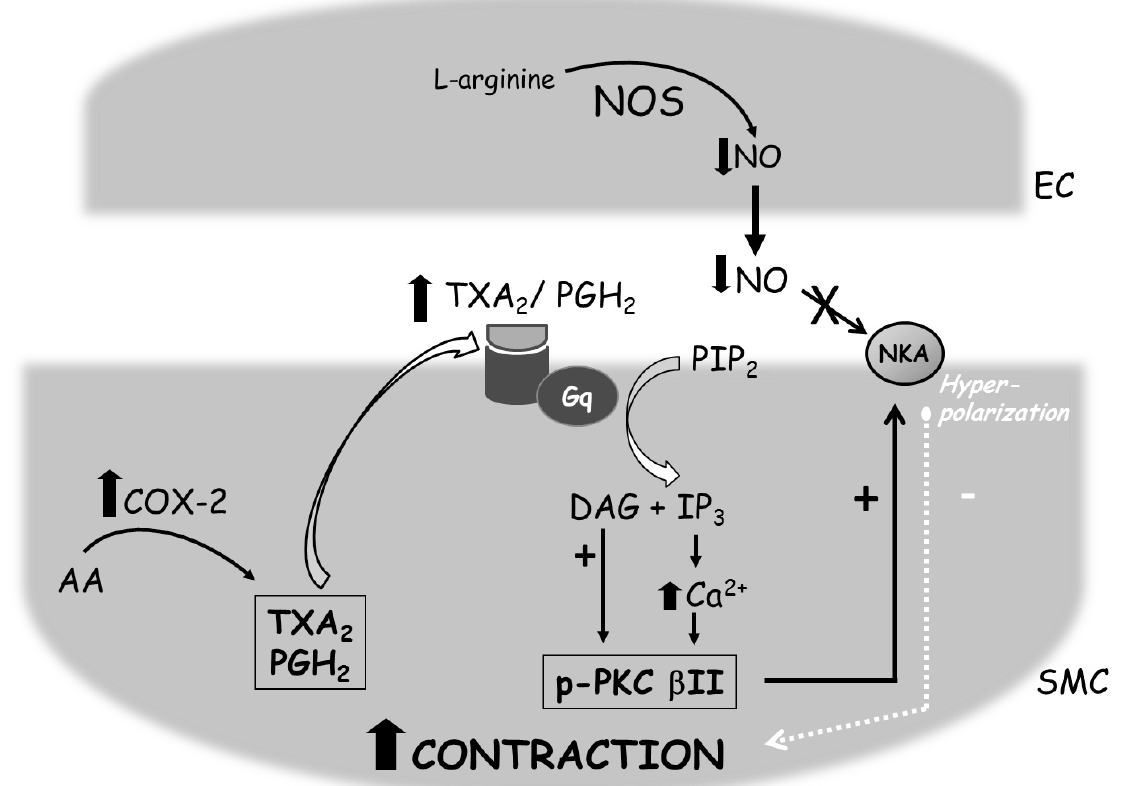
Figure 5. Schematic presentation of the proposed signal transduction pathway involved in altered Na + ,K + -ATPase activity induced by type I diabetes in aorta. The model shows vascular smooth muscle cell (SMC) containing the catalytic α-isoform of Na + ,K + -ATPase (NKA) and the abolished effect of endothelium-derived nitric oxide (NO) on this enzyme. Increased protein levels of cyclooxygenase-2 (COX-2) in SMC elevated prostanoid (TxA 2 and PGH 2 ) synthesis and their autocrine activity via TxA 2 /PGH 2 receptor enhances the phosphorylated βII isoform of PKC (p-PKC βII), which increases vascular contractility but in turn activates NKA. EC = Endothelial cell; DAG = diacylglycerol; IP 3 = inositol trisphosphate; PIP 2 = phosphatidylinositol 4,5-bisphosphate. ! = increase; ! = decrease; Z = production and/or stimulation; dotted white line with arrow pointing downwards =